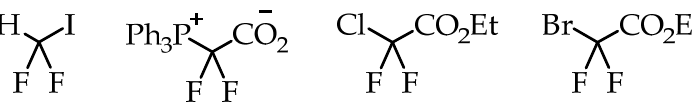
Figure 6. Difluororcarbene